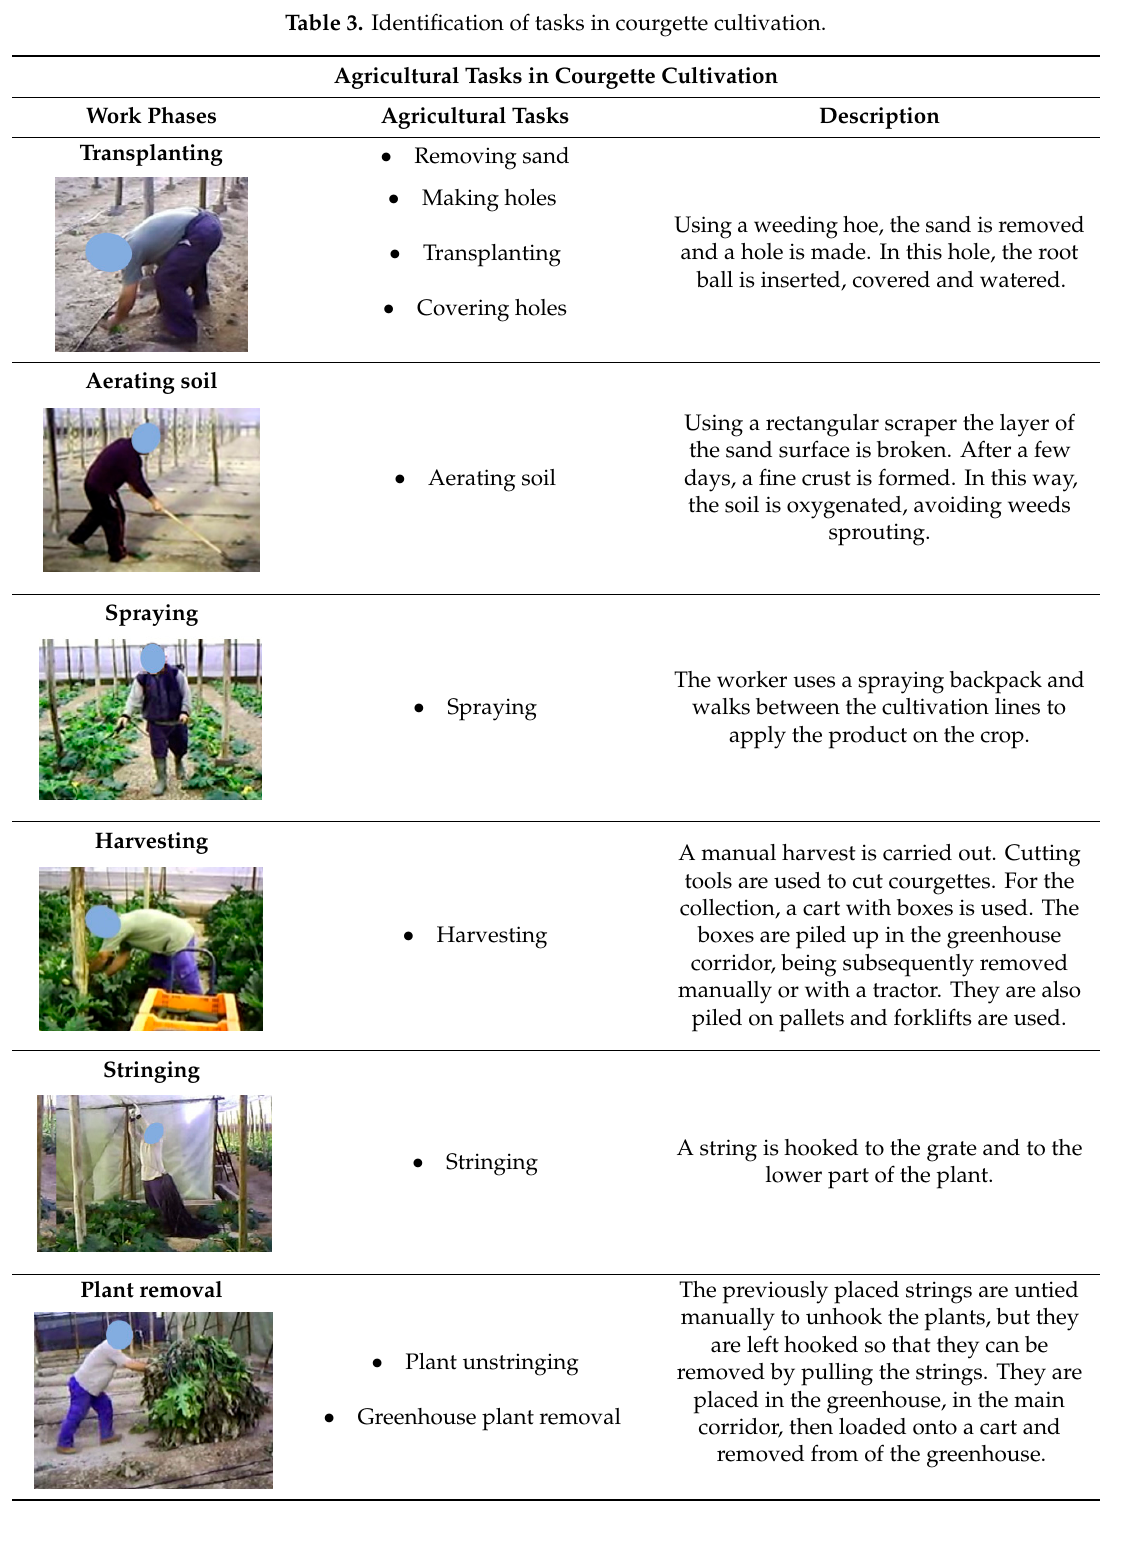
Table 3. Identification of tasks in courgette cultivation.